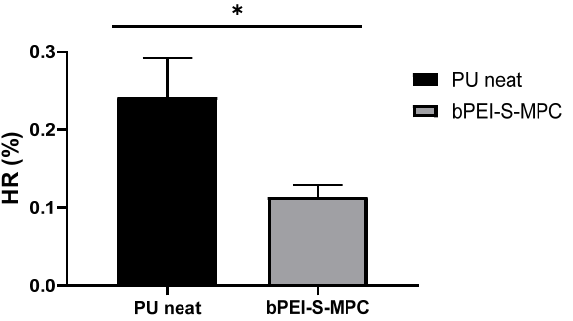
Figure 6. Hemolysis ratio of PU neat and bPEI-S-MPC ( n = 5, * denotes p < 0.01).